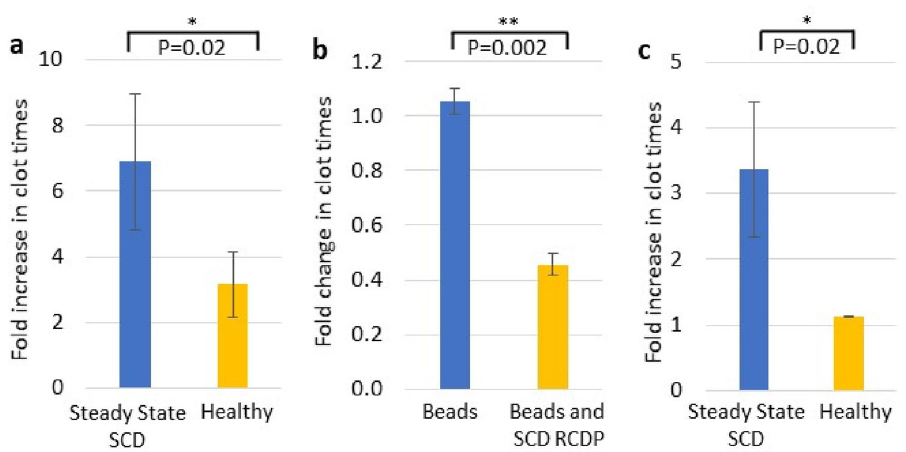
Figure 4. Phosphatidylserine decorated RCDP are major contributors to hypercoagulability in SCD. RCDP were selectively removed from SCD PFP using an anti-glycophorin A antibody attached to magnetic microbeads. After RCDP removal the clotting times were assayed ( a ) and found to increase (steady state SCD blue, healthy individual yellow). Average steady state SCD clotting times was 129.9 s and average healthy clotting times was 153.7 s. The amount of RCDP removal was; steady state SCD, 94.1% of all RCDP present at start and healthy 88.8% of all RCDP present at start. ( b ) When SCD RCDP are added to healthy PFP the clotting times are reduced (mean SCD RCDP addition to healthy PFP 3788 events per µl as assayed by imaging flow cytometry) (blue—healthy PFP with just microbeads and yellow—healthy PFP with SCD RCDP attached to microbeads). ( a ) and ( b ) n = 6 SCD samples and n = 3 healthy samples. ( c ) Healthy and steady state SCD PFP (n = 4 SCD samples and n = 2 healthy samples) was passed through a 1.2 µm filter and samples analysed by imaging flow cytometry to determine changes in RCDP (mean removal rates; steady state SCD, 1.9% of all low scatter RCDP present at start, 3.4% of all high scatter (not including MaV) RCDP present at start and 95.8% of all MaV present at start and healthy, 17.5% of all low scatter RCDP present at start, 0.83% of all high scatter (not including MaV) RCDP present at start and 68% of all MaV present at start) and clotting times found to increase after filtration (steady state SCD blue, healthy